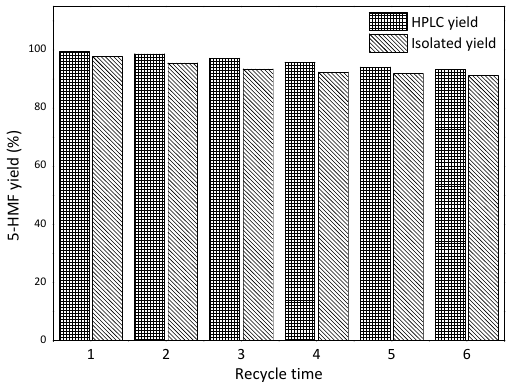
Figure 6. Recycle of CePW 12 O 40 and sec ‐ butanol (5.48 mg/mL of fructose, 1.0 g of catalyst, 158 °C, 164 min).